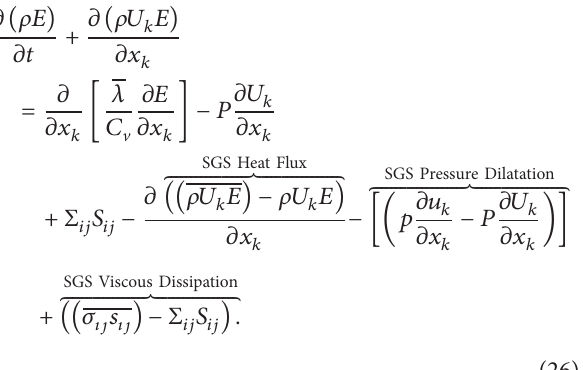
(22.644 cells), fine (249.084 cells), and extra fine